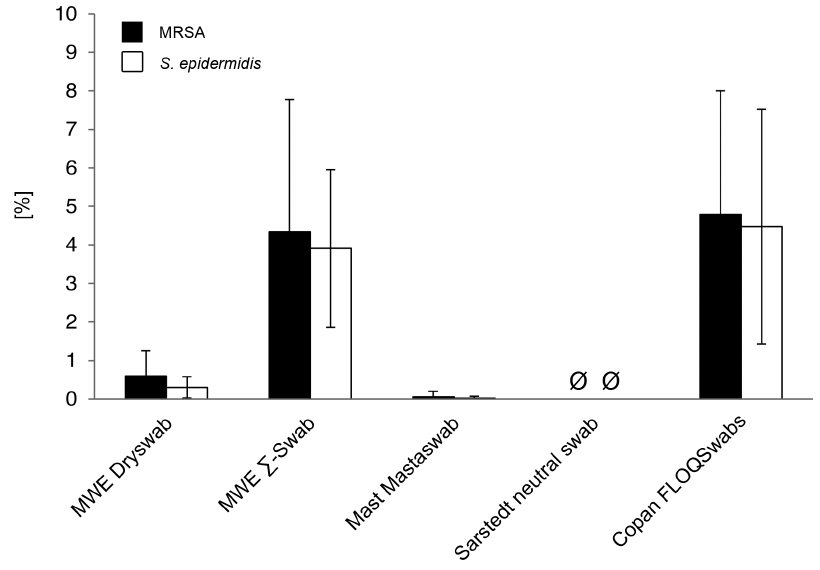
Figure 3. Relative recovery of bacteria compared to inoculation dose after direct plating. of viable counts of released bacteria to the inoculation dose, which was defined as 100%. Results from statistical analysis are shown in Table S2.